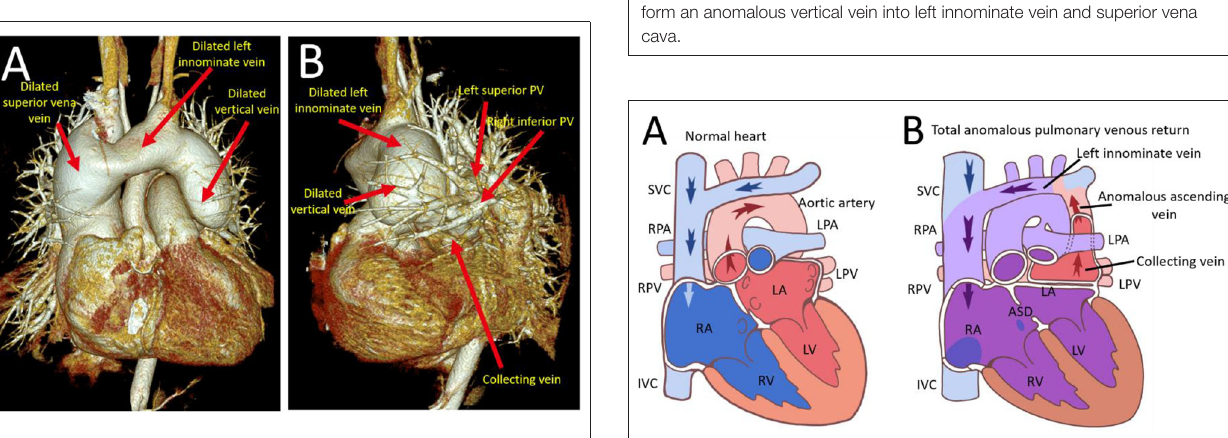
FIGURE 4 | Images of normal heart (A) and supracardiac TAPVR (B) were presented. ASD, atrial septal defect; IVC, superior vena cava; LA, left atrium; LPA, left pulmonary artery; LPV, left pulmonary vein; LV, left ventricular; RPA, right pulmonary artery; RPV, right pulmonary vein; SVC, superior vena cava; TAPVR, total anomalous pulmonary venous